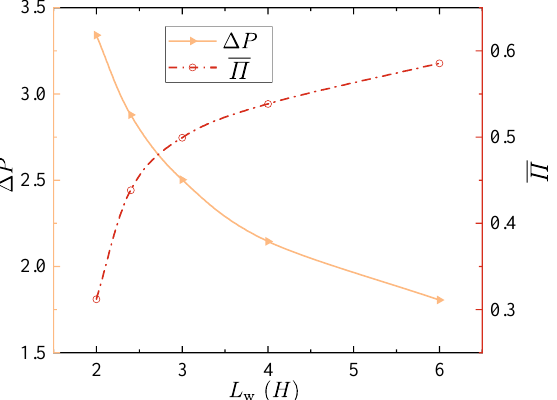
Figure 9. Profiles of the dimensionless ( a ) velocity, ( b ) temperature, ( c ) shear rate and ( d ) viscosity in the transverse direction at the outlet of test section for different wavelengths. The amplitude of the wave is 1/5 H , and Re gen,CY is 130.